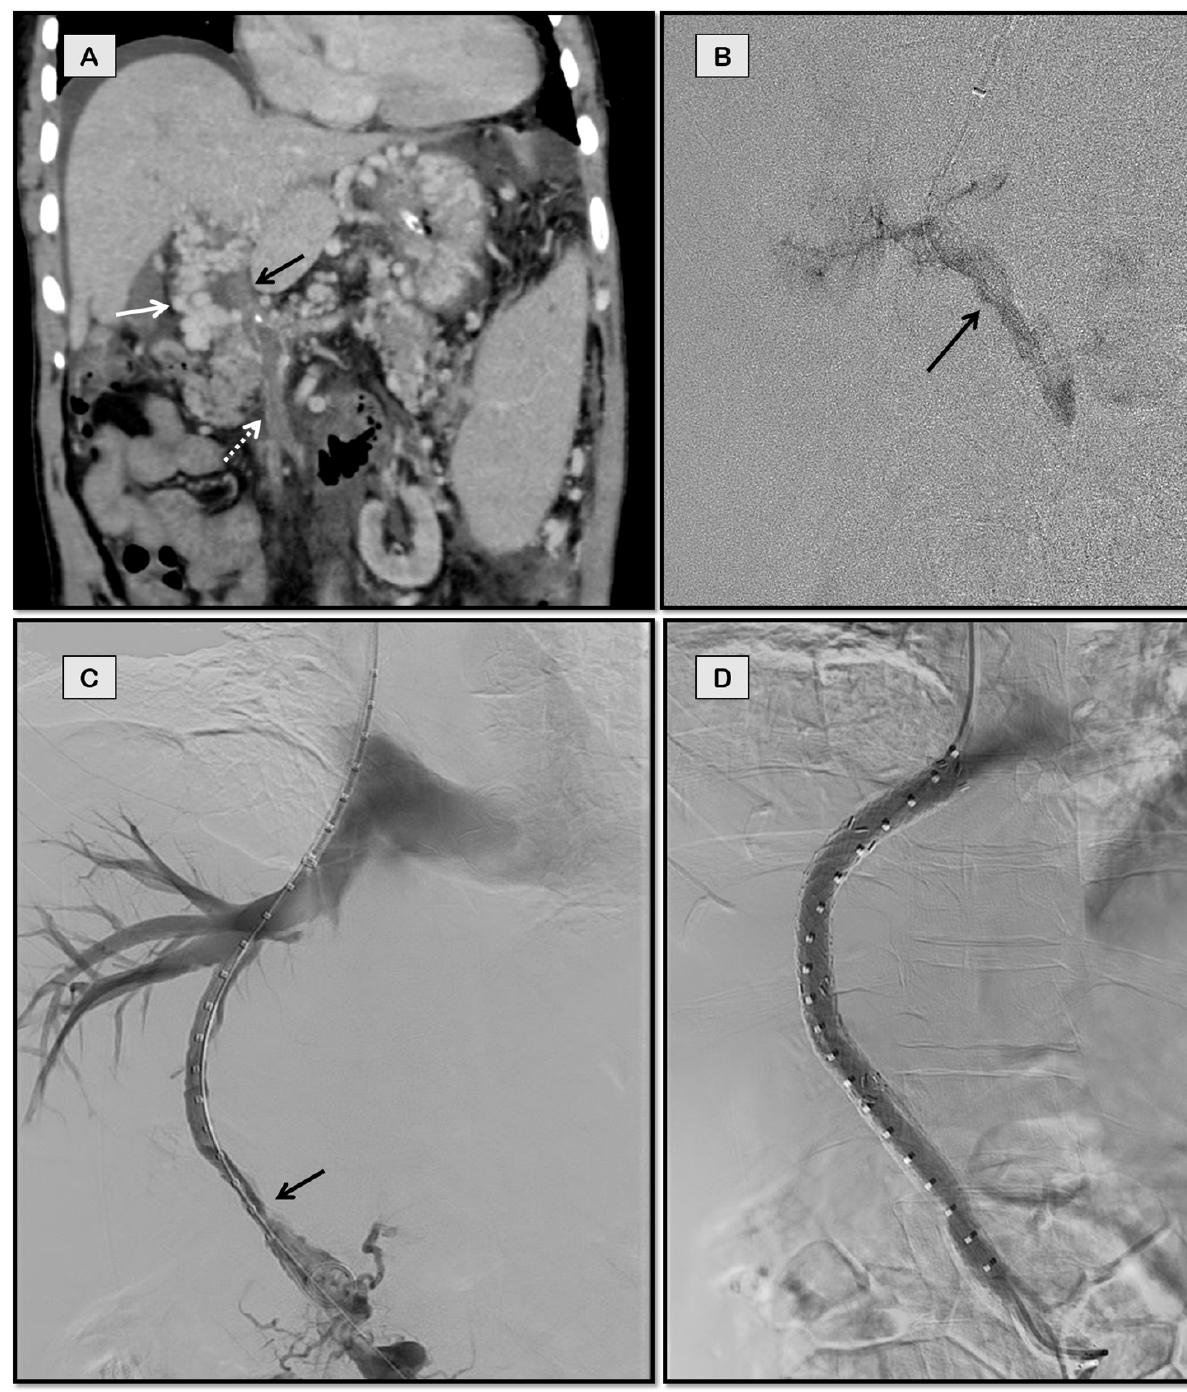
Figure 1. TIPS in a 61-year-old man with polycythemia vera and chronic porto-mesenteric vein thrombosis who presented with recurrent variceal bleed refractory to endoscopic therapy. Patient was not a surgical candidate due to multiple comorbidities. Coronal-oblique image ( A ) from the computed tomographic (CT) scan of the patient showing chronic thrombosis of the portal vein (black arrow) and superior mesenteric vein (dashed arrow) with cavernoma formation (white ar- row). Fluoroscopic spot image ( B ) shows the thrombosed portal vein (arrow) accessed from jugular approach. Post balloon maceration and thromboaspiration, there is partial recanalization of the por- tal and superior mesenteric vein ( C ). Post-stenting ( D ) image shows brisk flow through the stent with absence of collateralization.